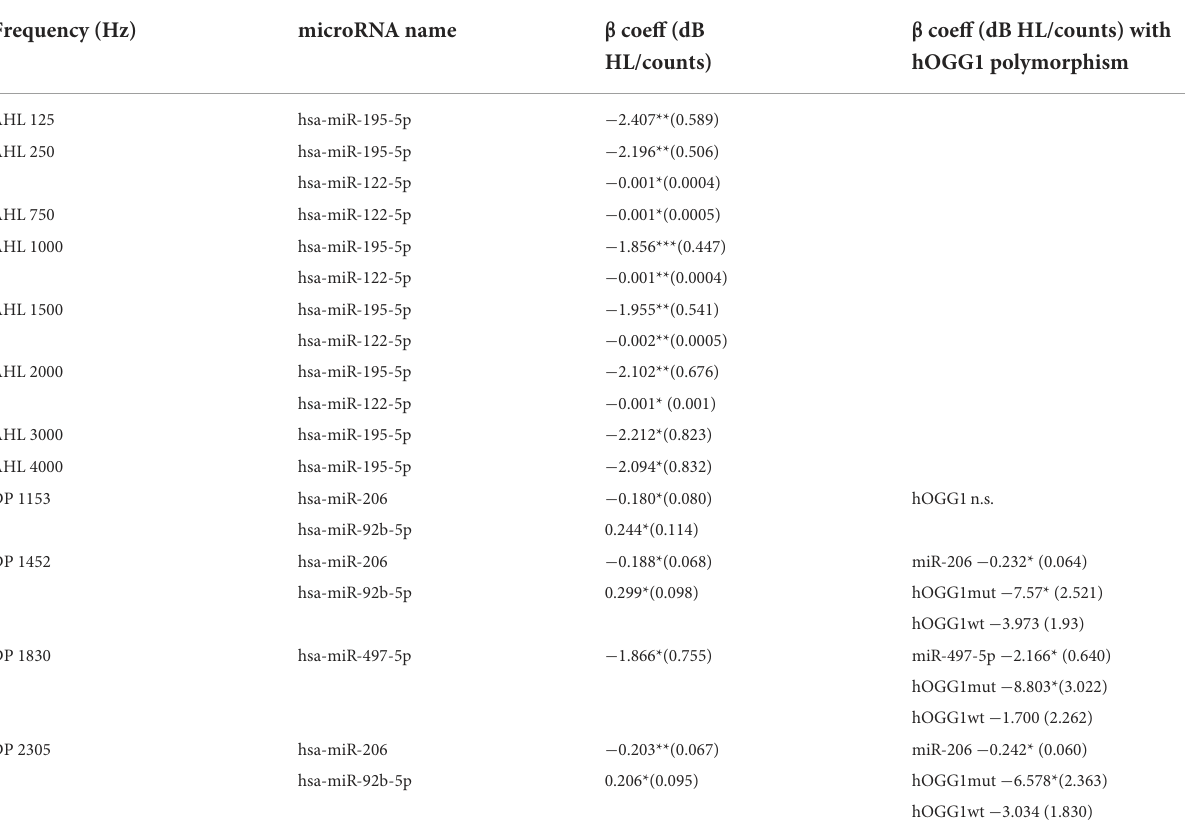
TABLE 2 Lme fit results for the audiological variables, audiometric hearing level (AHL), and DPOAE level (DP). The beta β coefficients are reported along with their standard